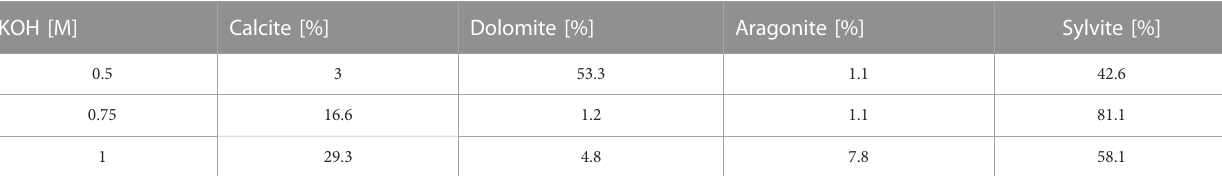
TABLE 5 XRD analysis for the effect of increasing pH with KOH for a sample consisting of 1 M urea, 0.6 M CaCl 2 , 0.4 M MgCl 2 and 15 wt% enzyme. KOH [M]